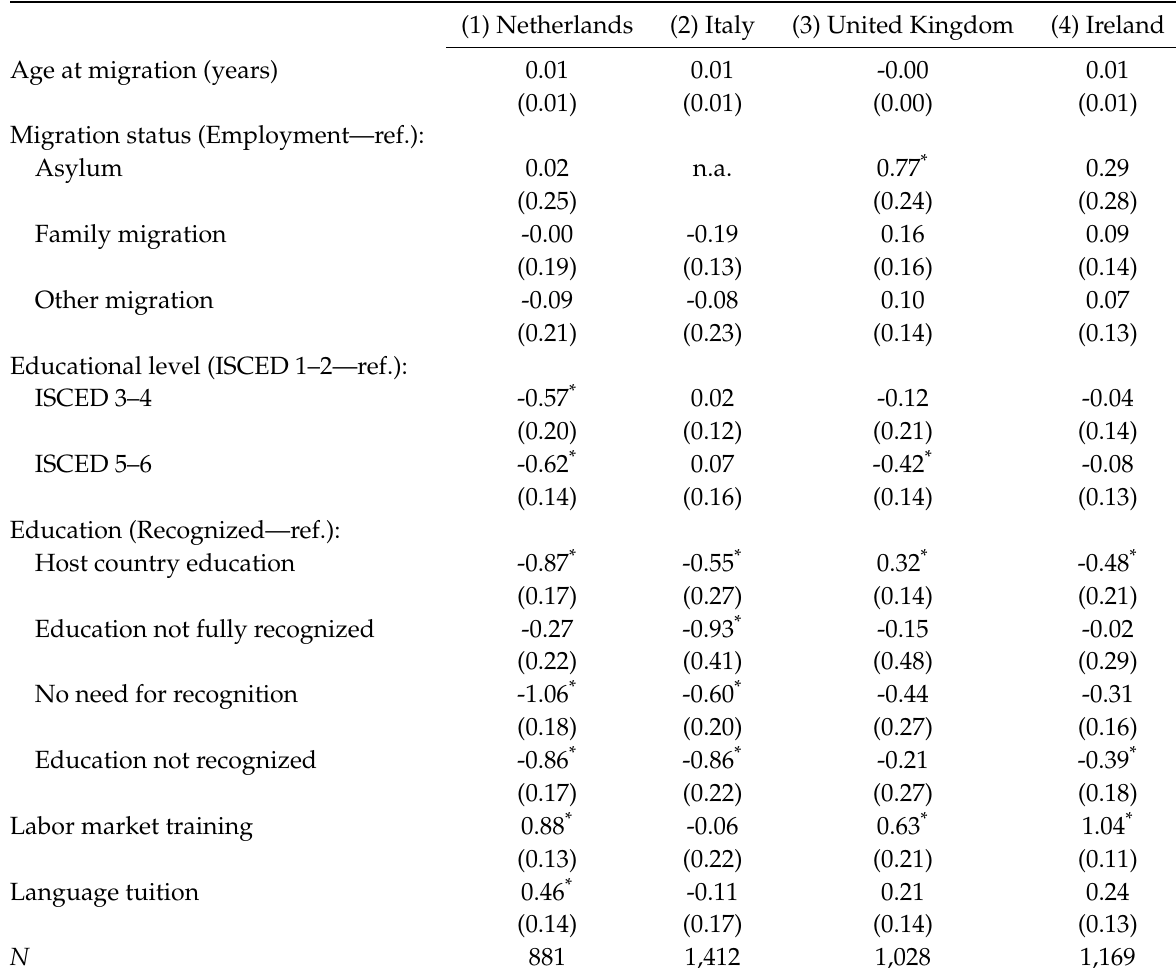
Table 2: Selected Predictors of Participation in Training (Results of the Probit Regression from the PSM